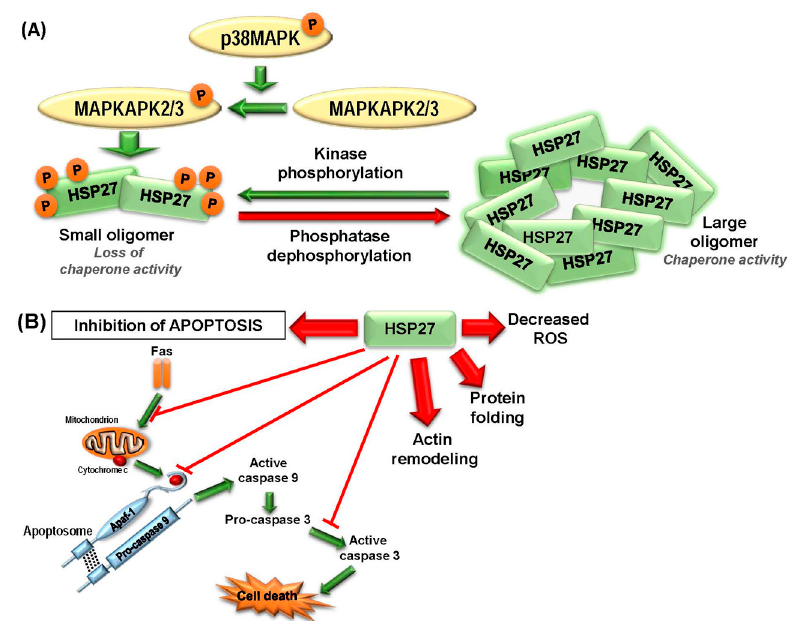
Figure 2. HSP27 mediated suppression of apoptosis promotes tumorigenesis. ( A ) Schematic representation of conformational structural switching between different states. HSP27 exists as large oligomers when unphosphorylated and performs their chaperonage activities. Upon phosphorylation at specific serine residues by activated mitogen-activated protein kinase (MAPK) pathway, HSP27 switches to smaller oligomers losing their chaperonage activities, but gaining their pro-oncogenic functions. Green arrow represents activation via phosphorylation and red arrow represents deactivation via dephosphorylation. ( B ) HSP27 has important functions in regulating protein folding, actin cytoskeleton, decreasing oxidative stress and suppression of apoptosis and other forms of cell death. Hyperactivation of HSP27 can induce blockage at multiple steps of apoptosis as shown in the figure. Upregulation of HSP27 is a critical survival mechanism for the stressed cell and is co-opted by the malignant cell to adapt to and survive cellular stress. Phosphorylation status determines the importance of some of HSP27’s interactions, however, for simplicity, it is not addressed in this figure. Green arrows indicate the activation steps involved in apoptosis. Red arrows originating from HSP27 represent induction of different processes.